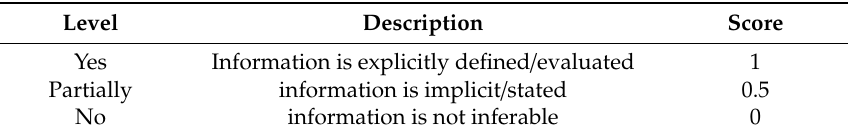
Table 1. Quality assessment